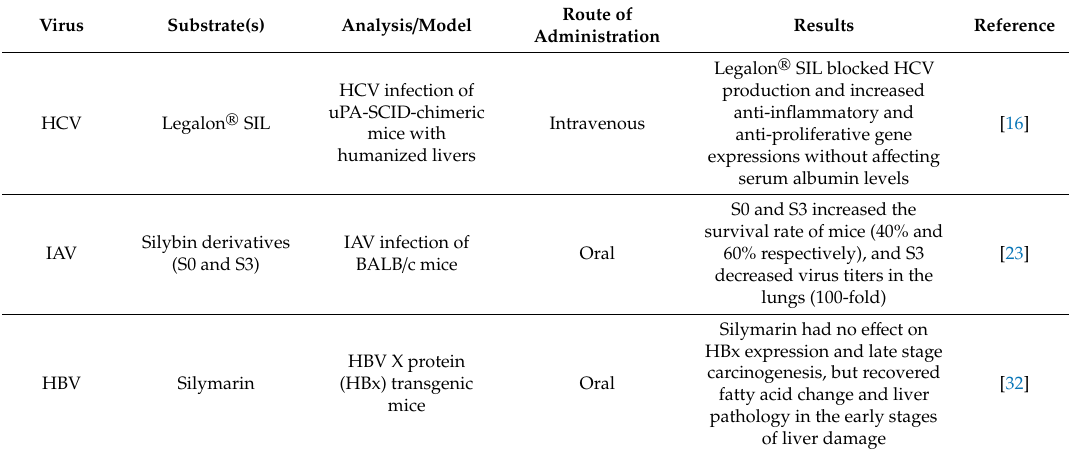
Table 2. Preclinical studies of silymarin and derivatives in